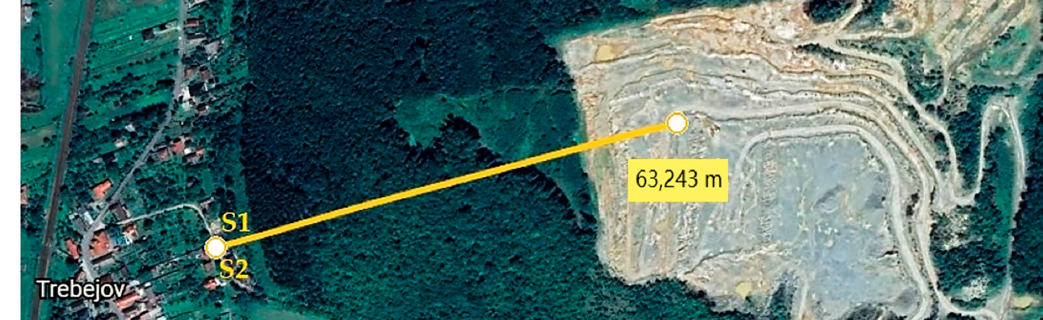
Figure 7. Measuring points S1 and S2 [5960, (source: author)].